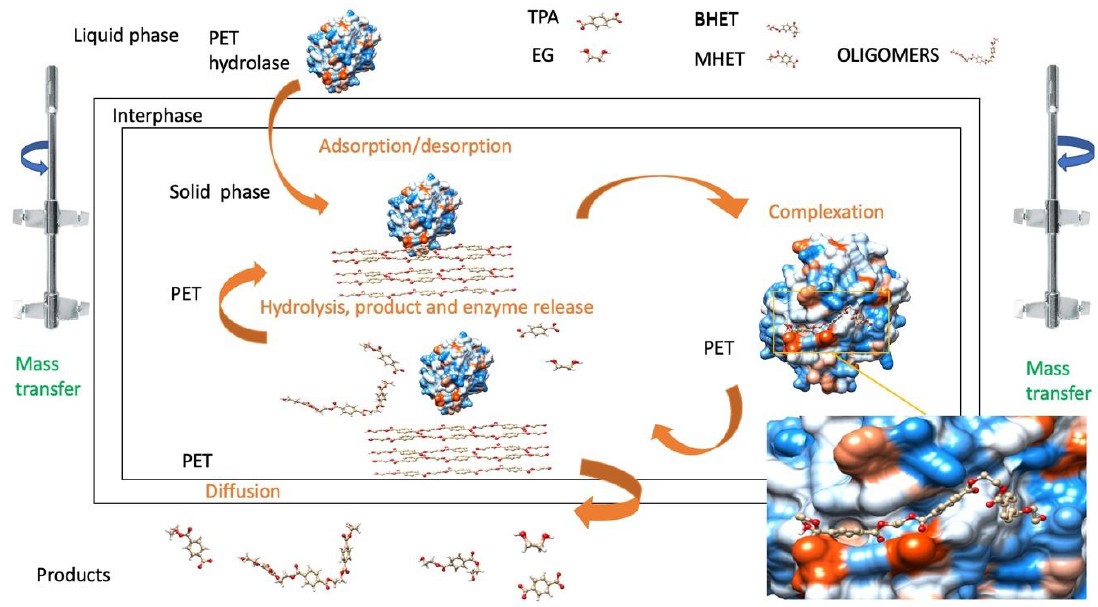
Figure 4. Scheme of the main steps of the mechanism of interaction and depolymerization between PET hydrolases and PET, improved by mass transfer.